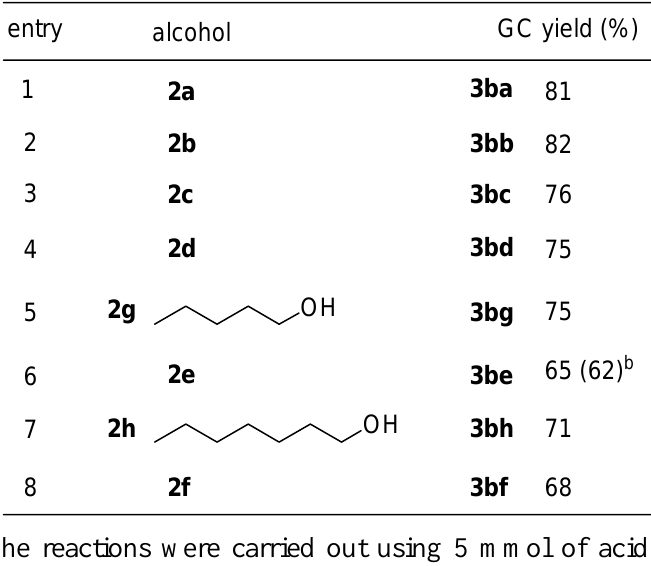
·8H O-catalyzed esterification of propionic acid ( 1b ) with alcohols Table 3. ZrOCl 2 2